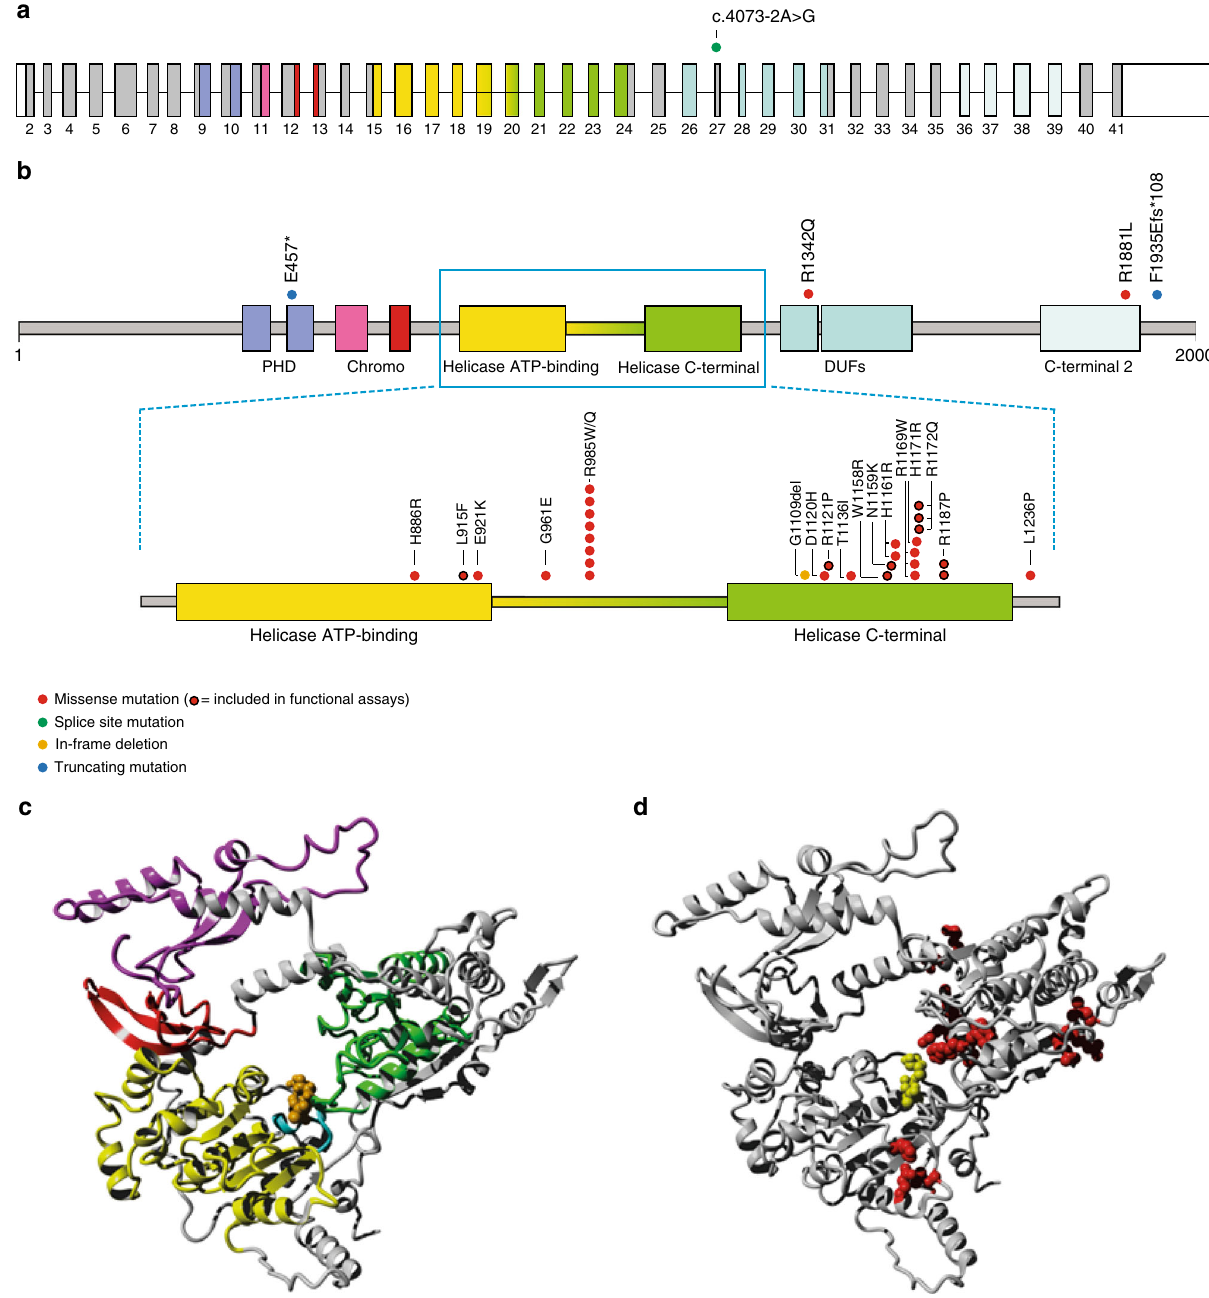
Fig. 2 Schematic view of CHD3 transcript and protein with de novo mutations. a Schematic view of CHD3 exons (transcript 1, NM_001005273.2) with the splice site mutation c.4073-2A>G shown that most likely leads to skipping of exon 27 (22 amino acids), while preserving the reading frame. Exon 27 is part of the beginning of the second DUF domain (DUF 1086). Colors of the domains in a match with colors of domains in b and c . Five different types of domains are speci fi ed: plant homeodomains (PHD), chromodomains (Chromo), a Helicase domain consisting of two parts (Helicase ATP-binding and Helicase C-terminal), domains of unknown function (DUF), and a C-terminal 2 domain. b Schematic view of linear CHD3 protein (transcript 1, NM_001005273.2) with all mutations, except for the splice site mutation that is shown in a , found in our cohort. Almost all missense mutations cluster in or around the Helicase domain of the CHD3 protein. c Overview of one of the two CHD3-models used in this study, based on the 3MWY protein structure. This fi gure shows the different domains of the protein in their three-dimensional conformation: chromo domain 1 494 – 595 (magenta), chromo domain 2 631 – 673 (red), helicase ATP binding domain (yellow), helicase C-terminal domain (green), ATP binding residues 761 – 768 (cyan). ATP is orange, and gray residues do not belong to an indicated domain. Colors of the domains in c match with colors of domains in a and b . d The same structure as c , but in this fi gure the positions of the mutated residues are indicated in red, the sidechains of these residues are shown as red balls. The ATP molecule is shown in yellow. This fi gure illustrates the clustering of mutations on speci fi c sites within the Helicase ATP-binding domain and Helicase C-terminal domain. A more detailed analysis of the different missense mutations in our cohort can be found in Supplementary Note